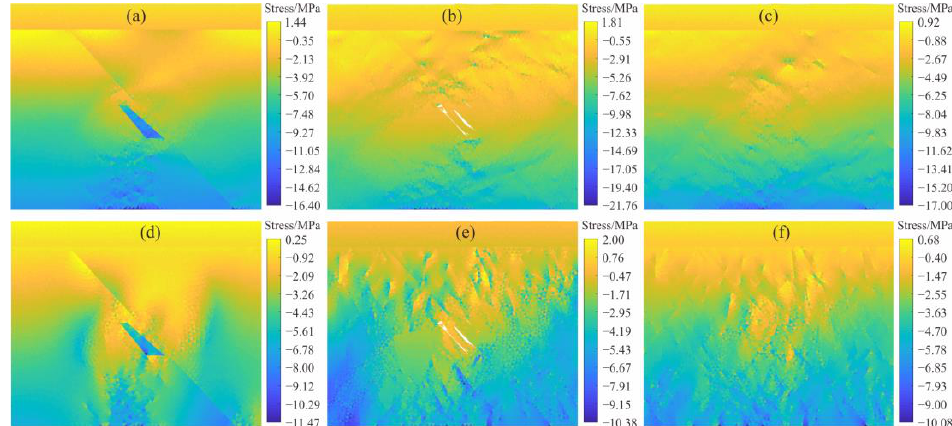
Figure 10. Stress distribution in the surrounding rock. ( a ) Horizontal stress under the condition of backfill mining without fissures; ( b ) horizontal stress under the condition of mining with fissures; ( c ) horizontal stress under the condition of backfill mining with fissures; ( d ) vertical stress under the condition of backfill mining without fissures; ( e ) vertical stress under the condition of mining with fissures; and ( f ) vertical stress under the condition of backfill mining with fissures.